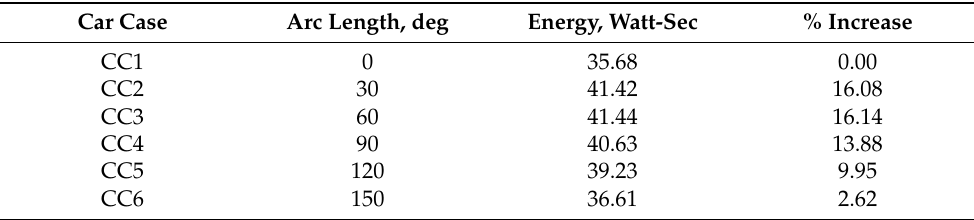
Table 3. Energy produced by VAWT in one pass of car for each case.